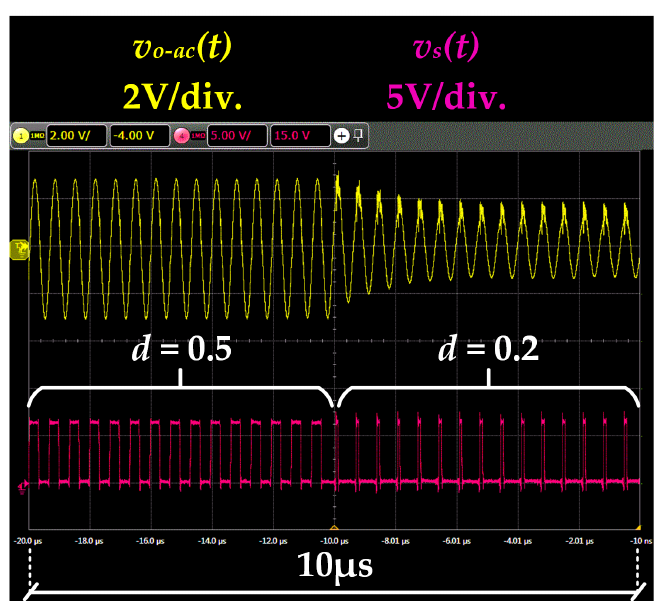
Figure 16. Prototype response to duty cycle change from 0.5 to 0.2.